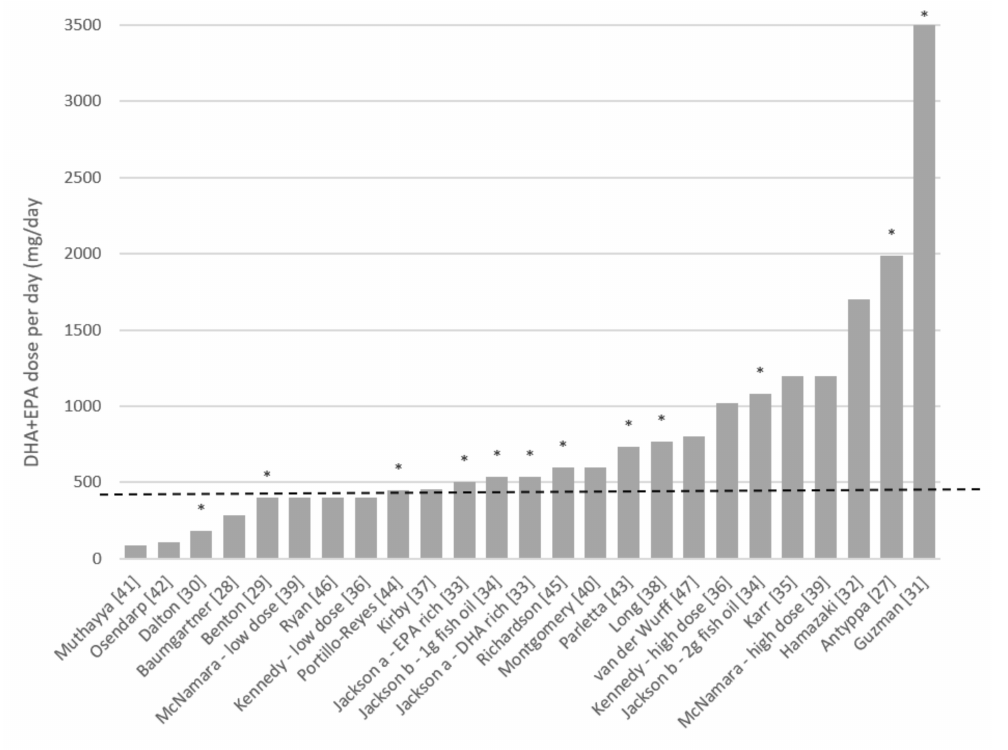
Figure 3. n -3 long-chain polyunsaturated fatty acids (LCPUFA) supplementation studies that studied cognition in typically developing children. Studies indicated with a * are those studies in which positive effects of supplementation on cognition are reported. Dotted line indicates supplementation of 450 mg docosahexaenoicacid(DHA) + eicosapentaenoicacid(EPA)perday. NotethatinthestudyofHamazakietal. dose differed based on bodyweight. The dose noted here is the lowest dose. Note that Jackson, Kennedy and McNamara included two n -3 LCPUFA dose groups, these are reported separately